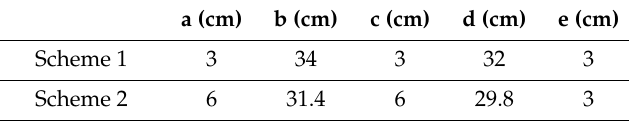
Figure 3. Schematic diagram of experimental grille. ( a ) Front view; ( b ) side view. Table 1. Dimensions of the experiment